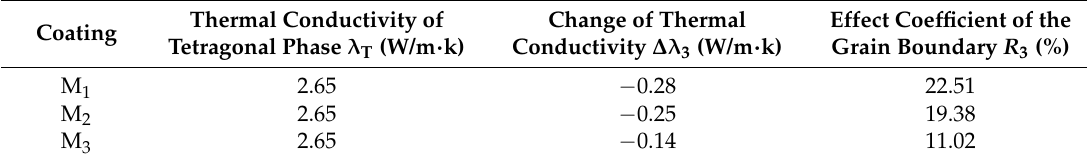
Table 8. Effect coefficient of grain boundaries R 3 and the amount of change in thermal conductivity ∆ λ 3 . Thermal Conductivity of Change of Coating Tetragonal Phase λ T (W/m · k)